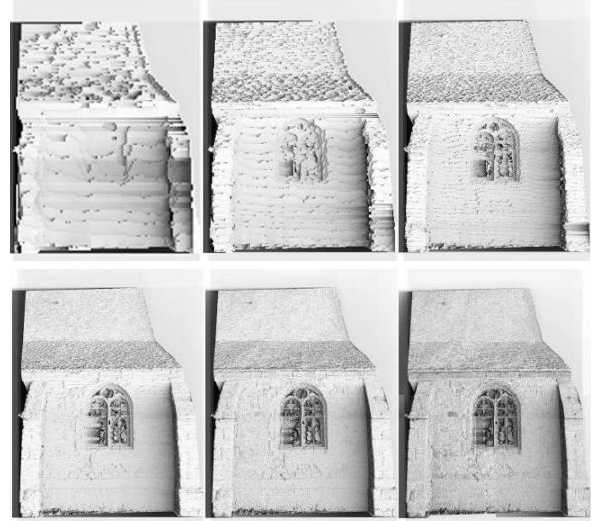
Figure 1: Pyramidal approach: example of results during the multi-scale matching